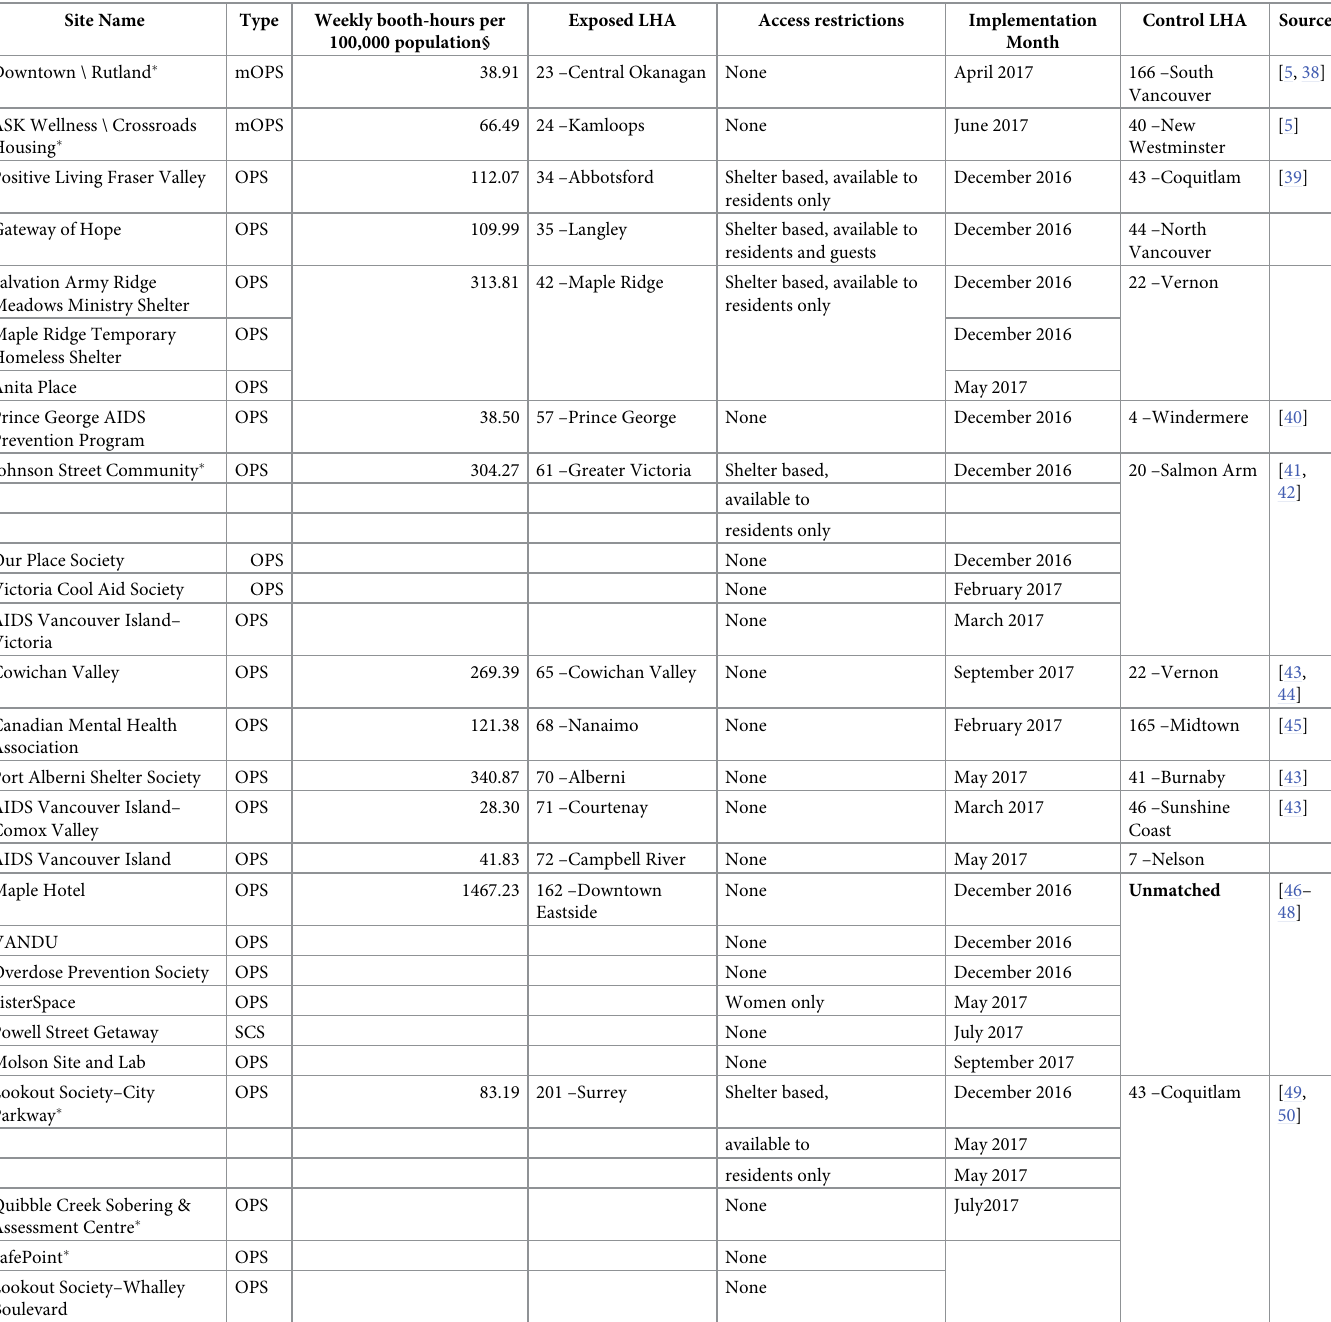
Table 1. Implementation month-year and location of overdose prevention site or supervised consumption site, with propensity score matched local health area. Site